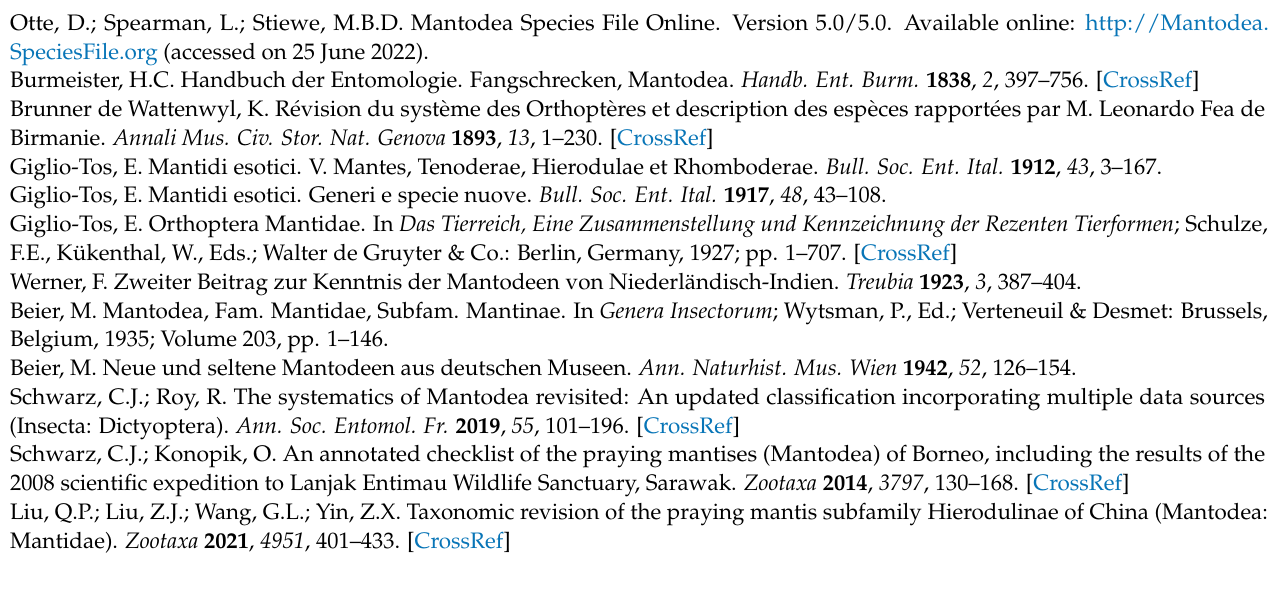
the ML analysis from AA-no partition dataset. Figure S3. Topology of the ML analysis from AA-gene partition dataset. Figure S4. Topology of the ML analysis from PCG12RNA-gene partition dataset. Figure S5. Topology of the ML analysis from PCG12RNA-no partition dataset. Figure S6. Topology of the ML analysis from PCGRNA-no partition dataset. Figure S7. Topology of the BI analysis from AA-no partition dataset. Figure S8. Topology of the BI analysis from AA-gene partition dataset. Figure S9. Topology of the BI analysis from PCG12RNA-gene partition dataset. Figure S10. Topology of the BI analysis from PCG12RNA-no partition